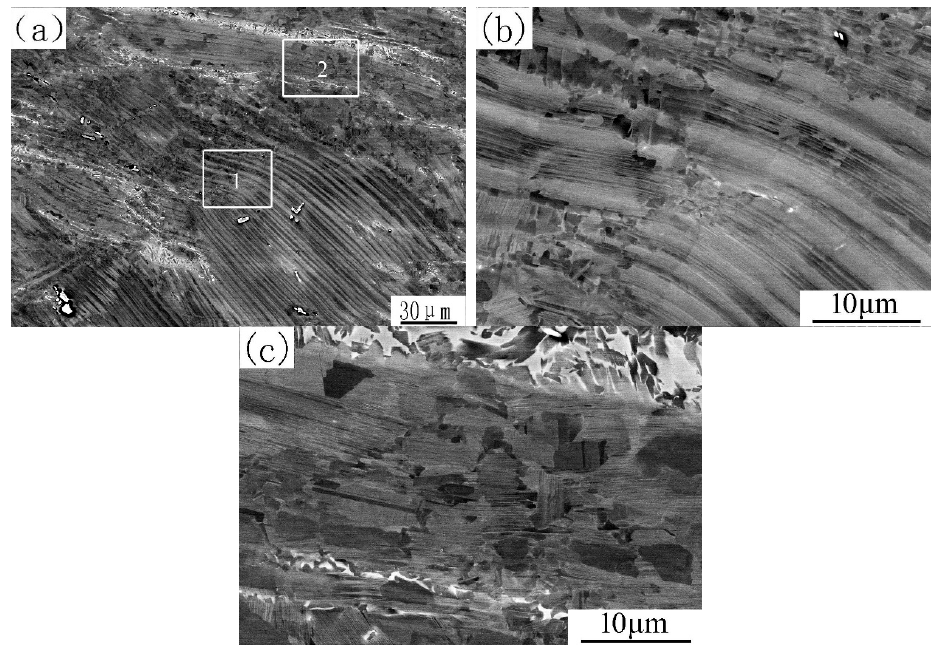
Figure 8. Microstructure of TZ close to SDZ: ( a ) low magnification image; ( b ) and ( c ) magnified images of areas 1 and 2 in ( a ), respectively.